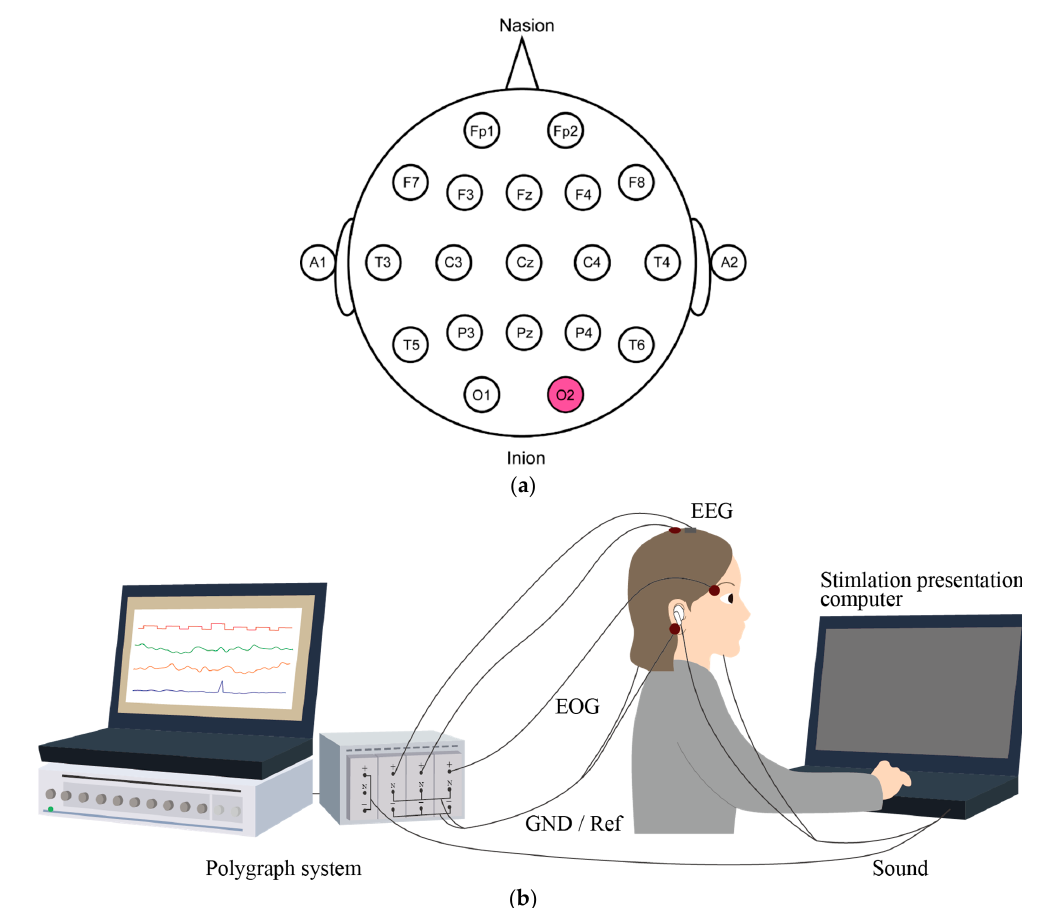
Figure 2. ( a ) Measurement sites of electroencephalogram (EEG) based on the 10–20 system. ( b ) Event-related potentials (ERPs) measurement system. EEG was measured from Cz with the conventional wet electrode and CME simultaneously. Auditory stimuli were presented to the participant. The signals were acquired and processed by the polygraph